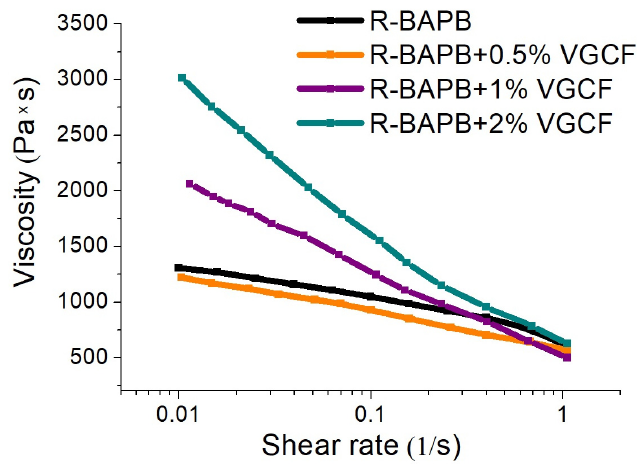
Figure 2. Dependence of viscosity on shear rate for R-BAPB modified with VGCF carbon nanoparticles. It should be noted that the fiber spinning occurred at the rates higher than 1 s − 1